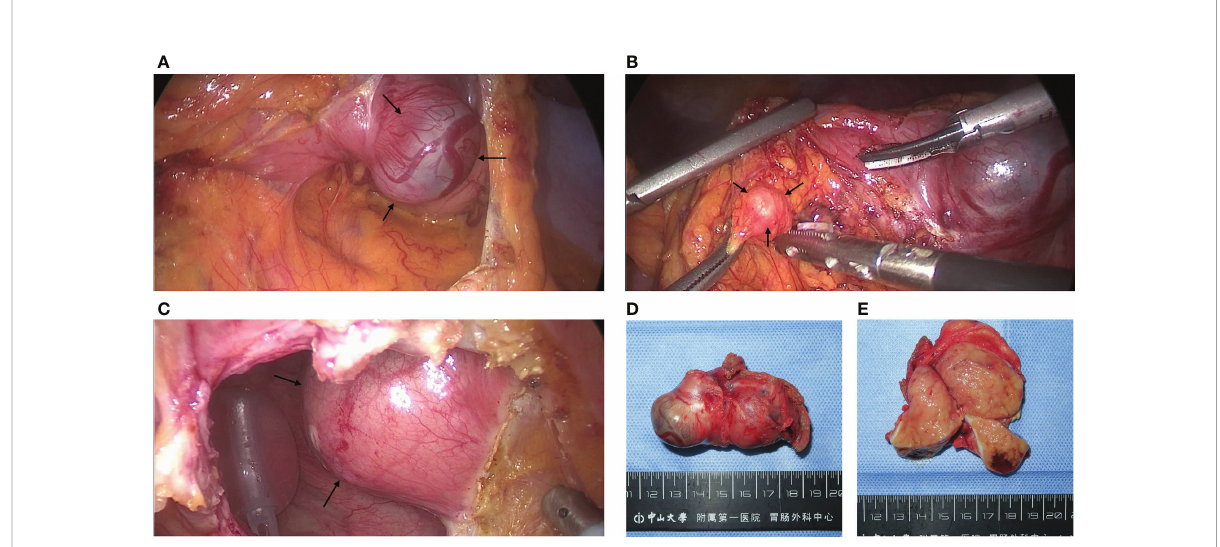
FIGURE 2 Pictures of GIST and PGL during and after surgery: (A) Intraoperative fi nding of a stromal tumor in the posterior wall of the gastric corpus which the arrows point to. (B) An enlarged nodule adjacent to the GIST pointed by arrows, which was initially suspected to be a lymph node metastasis from the stromal tumor but was diagnosed as hyperplastic fi brous connective tissue by cytopathology. (C) After incision of the peritoneum and the anterior wall of the bladder, a mass pointed by arrows on the right side of the bladder protruding into the bladder was found, which was con fi rmed by pathology as a PGL. (D, E) GIST after resection and its transverse section, approximately 6 cm in length. The tumor capsule was intact and limited, the section was brown, located in the inherent muscle